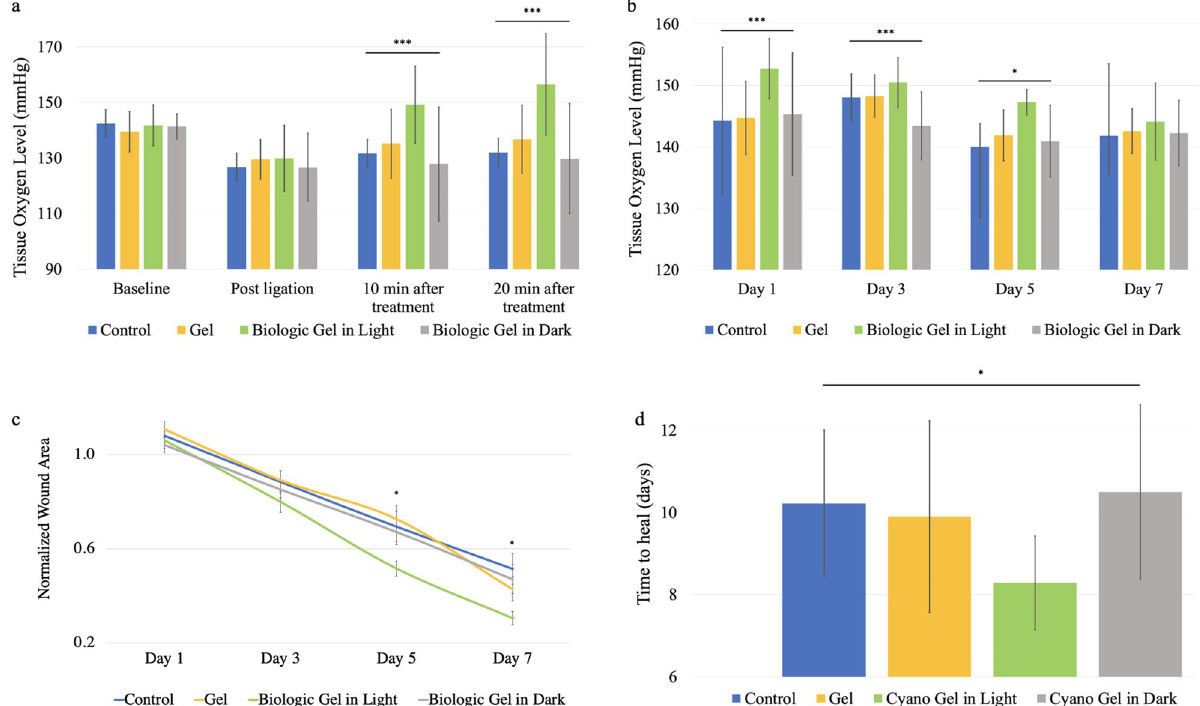
Figure 4. Tissue oxygenation and wound healing speed in a rodent peripheral arterial disease ischemic wound model. ( a ) After ligation, tissue oxygen level decreased from baseline (p < 0.0001 for all groups based on paired t-test). At 10 and 20 min after treatment, tissue oxygen levels were different among the groups at both time points (p < 0.0001) with post-hoc correction illustrating differences between biologic gel treatment in light compared to control, biologic gel treatment in dark, and gel (p = 0.001 for all comparisons at both time points). 40 animals were sacrificed for each treatment group. ( b ) ANOVA analysis demonstrated different tissue oxygenation level on day 1 (p < 0.0001), 3 (p < 0.0001), and 5 (p = 0.039) but not day 7 (p = 0.83) with post-hoc correction showing those that wounds received the novel biologic gel in light treatment demonstrated elevated tissue oxygenation level compared to control, biologic gel treatment in dark, and gel on day 1 (p = 0.001 for all comparisons), compared to biologic gel treatment in dark on day 3 (p = 0.001), and compared to control on day 5 (p = 0.04) after the ischemic injury. For each treatment group, day1: n = 40, day3: n = 32, day5: n = 24, day7: n = 16. ( c ) Normalized wound areas were similar among treatment groups on day 1 (p = 0.52) and day 3 (p = 0.38) but different on day 5 (p = 0.04) and day 7 (p = 0.05) from ANOVA with post-hoc correction showing wounds that received the novel biologic gel in light with the smallest unhealed normalized wound area after 5 days of treatment compared to gel (p = 0.04 from post-hoc correction). For each treatment group, day1: n = 40, day3: n = 32, day5: n = 24, day7: n = 16. ( d ) Wound healing speeds were different among the groups (p = 0.01) with post-hoc correction showing wounds that received the novel biologic gel treatment in light healed the fastest compared to biologic gel in dark treated wounds (p = 0.02) and controls (p = 0.05). Data presented as mean ± standard deviation except for (c) that was presented as mean ± standard error. The controls received no treatment. Controls: n = 9, gel: n = 10, novel biologic gel in light: n = 14, biologic gel in dark: n = 10. Statistics shown on the figure were resulted from ANOVA. * Indicates p < 0.05, ** indicates p < 0.01, and *** indicates p <